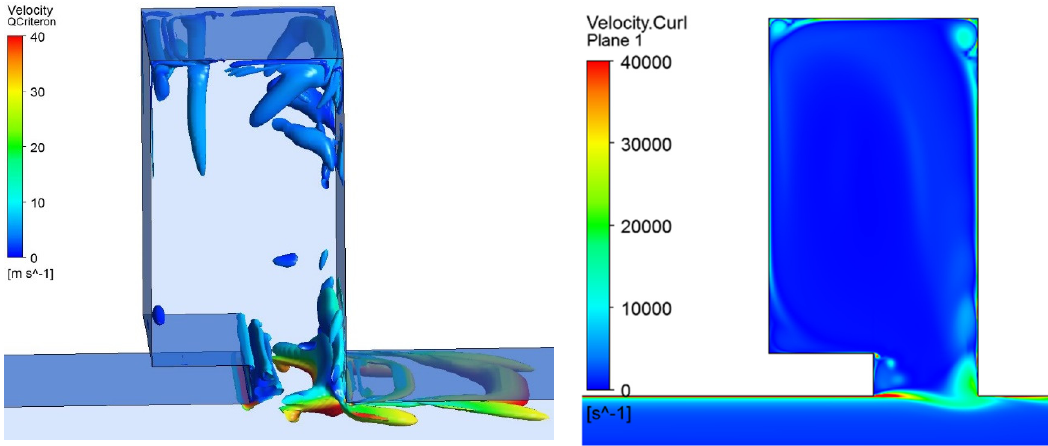
Figure 15. Instantaneous Q-criterion and vorticity distribution for velocity equal to 50 m/s—CFD.